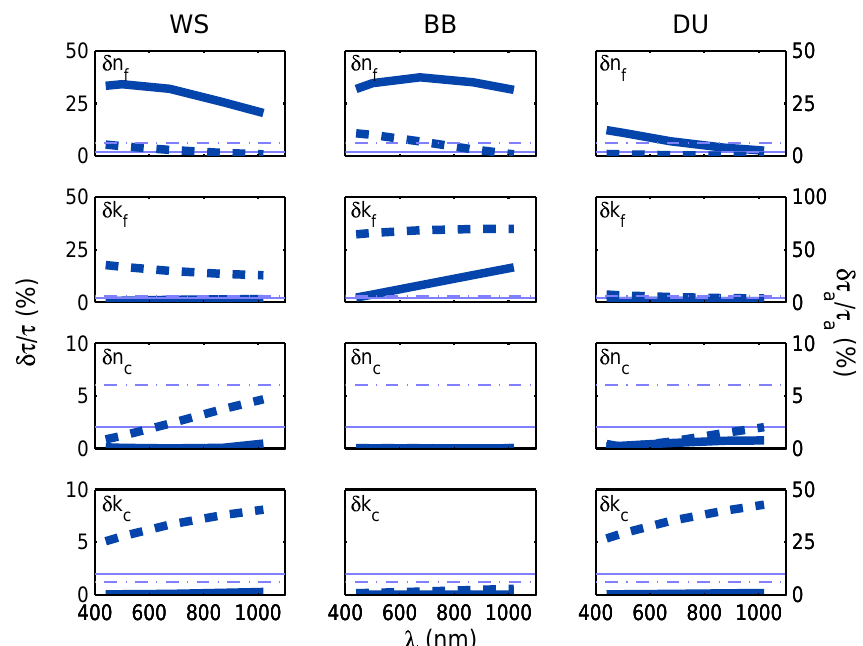
Figure 5. Sensitivity study on sub-mode CRI parameters ( n f ; k f , 440 ; n c ; k c , 440 ) to constrain parameters ( τ and τ a ) based on three aerosol types (WS: water soluble, BB: biomass burning, DU: dust). The thick solid line shows δτ/τ and the thick dashed line shows δτ a /τ a . The thin solid and dashed line in figure represent the sensitive thresholds (uncertainty of 2% for τ and 6% for τ a ).